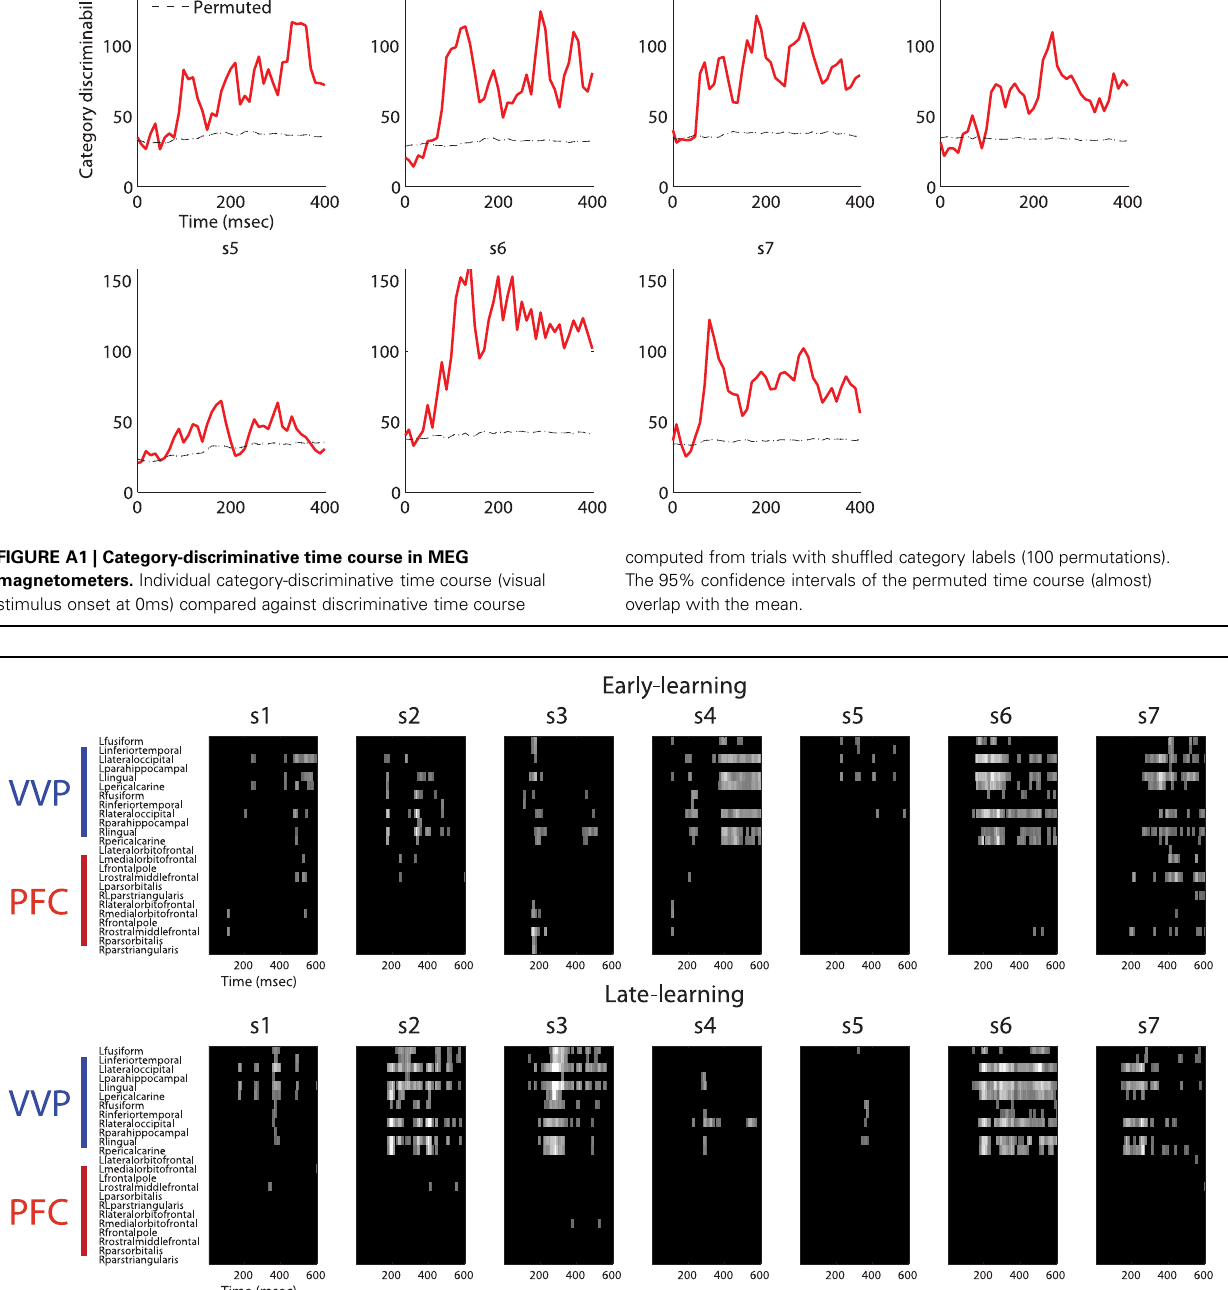
FIGURE A2 | Regions of interest in ventral visual and prefrontal cortices after excursion tests. The upper row shows regions of interest during early learning for each individual subject. The bottom